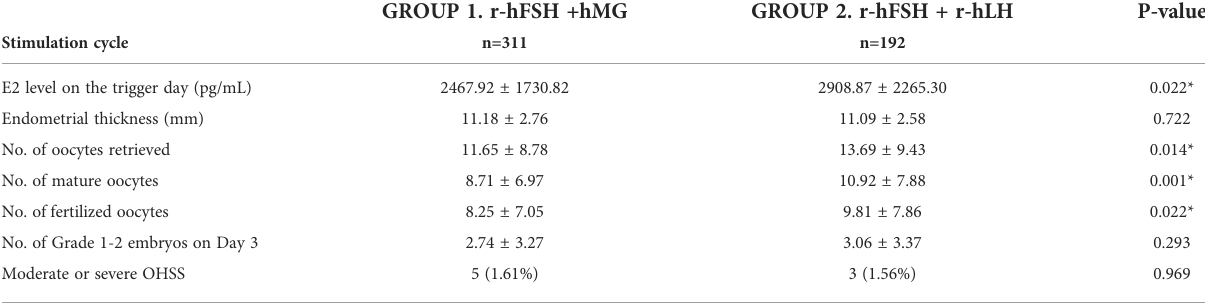
TABLE 2 Outcomes of total stimulation cycles after